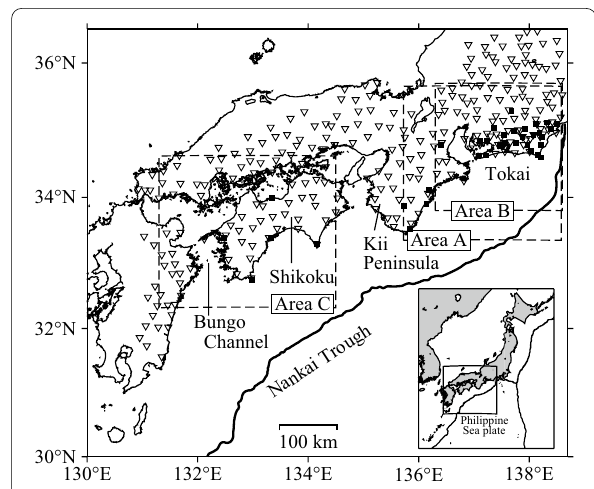
Fig. 1 Map of southwest Japan showing locations of JMA, Shizuoka Prefecture, and AIST strainmeter stations (solid squares) and NIED Hi-net tiltmeter stations (open triangles). The inset map shows the regional location and plate boundaries. Labeled rectangles indicate the areas of other figures